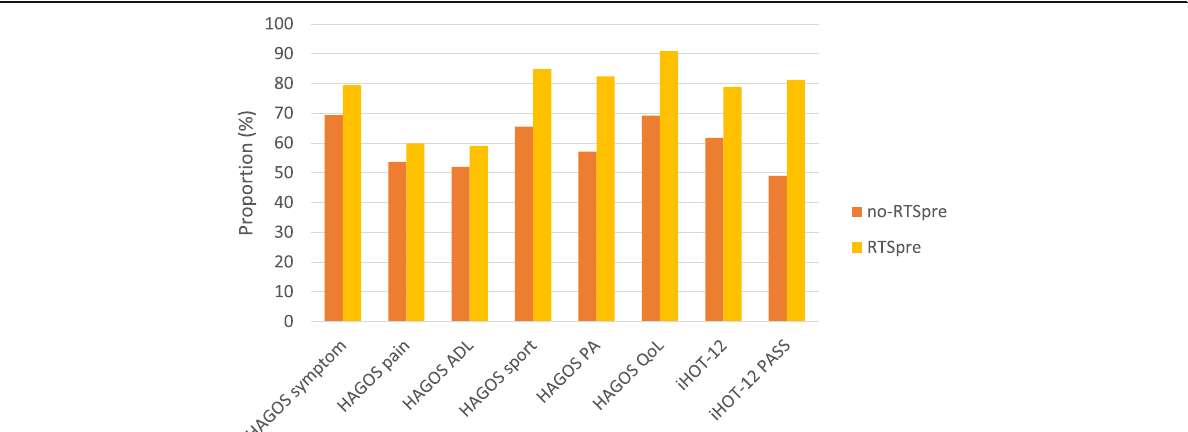
Fig. 2 Proportion (%) of RTS pre and no-RTS pre athletes reaching MIC in HAGOS six subscales and iHOT-12, and PASS in iHOT-12, two years postoperatively. RTS pre , active at pre-injury level; no-RTS pre , not active at pre-injury level; ADL, Activity of Daily Living; PA, Physical Activities; QoL, Quality of Life; MIC, minimal important change; PASS, patient acceptable symptomatic